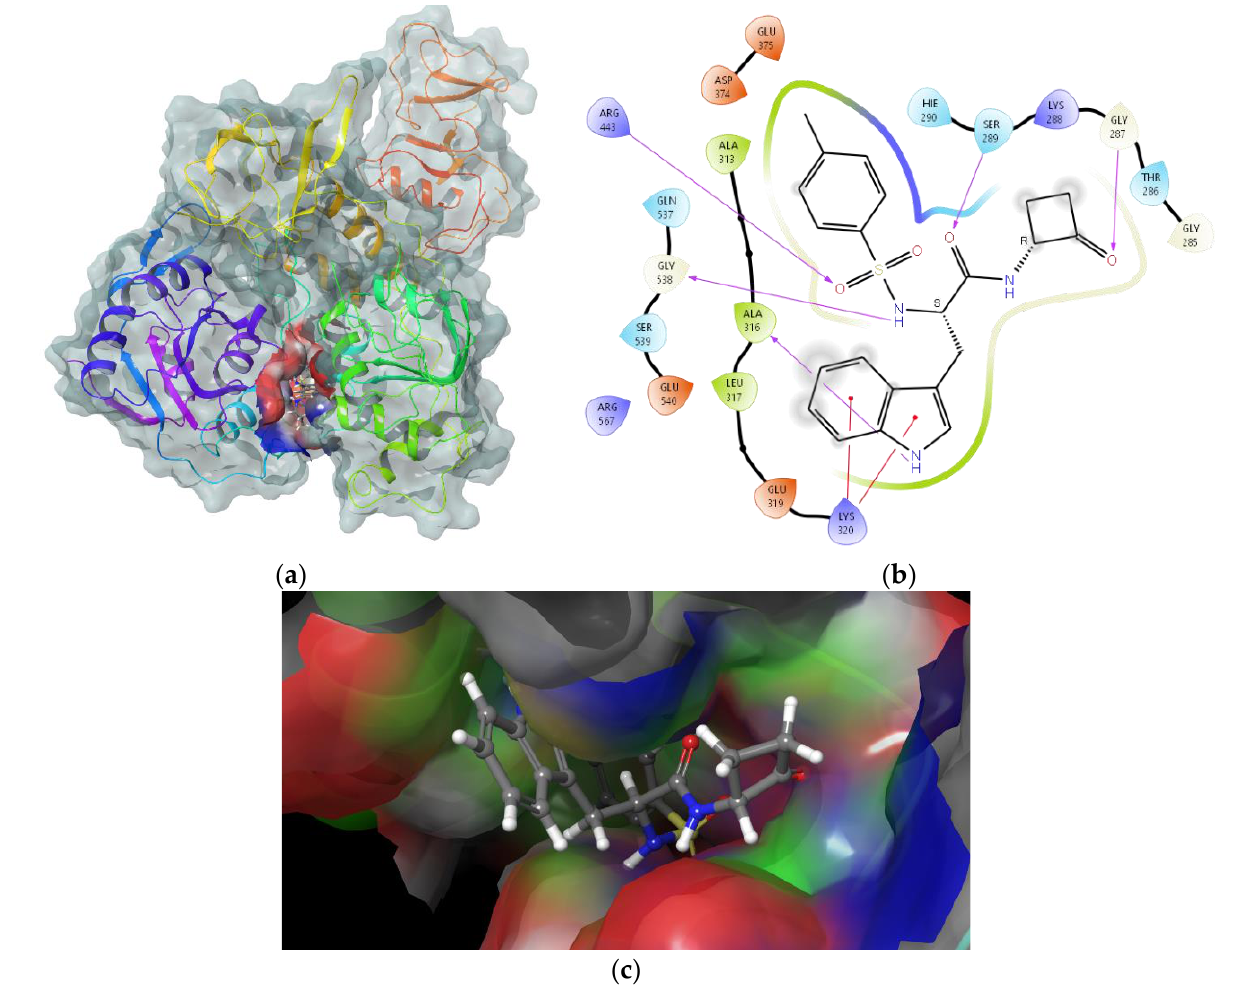
Figure 6. Docking image showing binding interactions of tosyl-(S)-Trp-(R)-aminocyclobutanone 4 in the ATP binding site of SARS-CoV-2 Nsp13 helicase, where ( a ) shows the position of inhibitor 4 in the helicase enzyme, ( b ) reveals key helicase-inhibitor interactions in a 2D interaction map, and ( c ) provides an image of 4 in the active site.